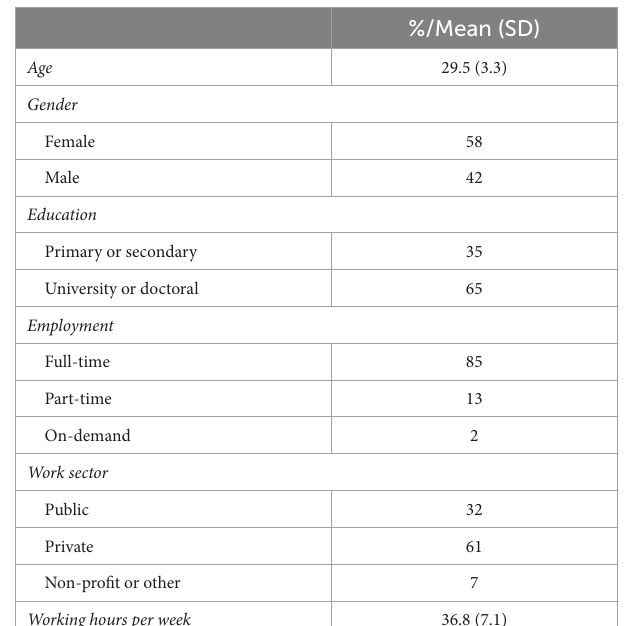
TABLE 1 Sample characteristics ( n =